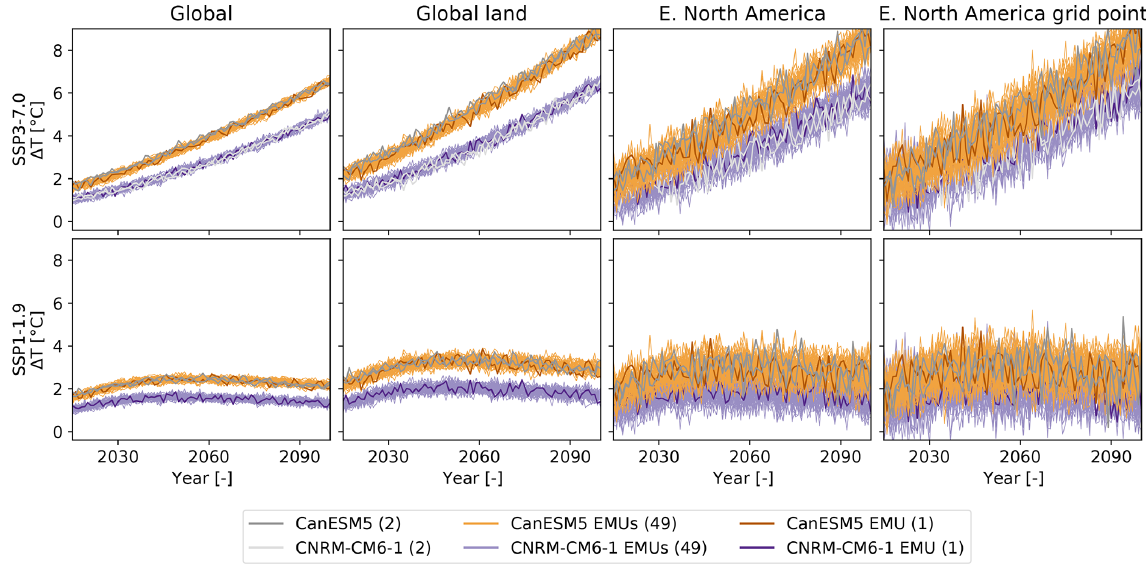
Figure 5. Temperature anomaly time series of ESM-specific MAGICC–MESMER emulations (in color) and actual ESM simulations (in gray) for CanESM5 and CNRM-CM6-1 averaged across different spatial scales: global, global land, eastern North America, and a single grid point within eastern North America for a high-emission (SSP3-7.0) and a low-emission (SSP1-1.9) scenario. For illustrative purposes, 50 out of the 600 available emulations are shown for both ESMs in color, and a single emulation is highlighted in a darker color. For the ESMs, two initial-condition ensemble members are shown for each scenario for which simulations are